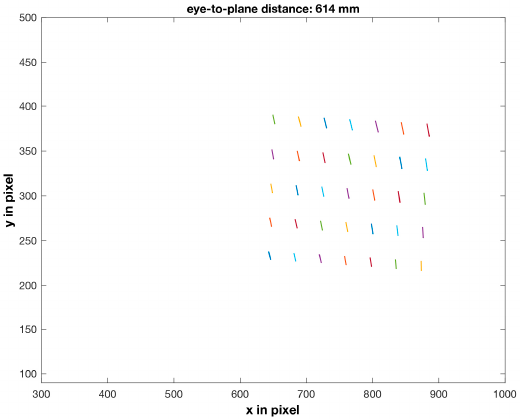
Figure A9. Map of disparities for a target plane placed at 614 mm from the observer.